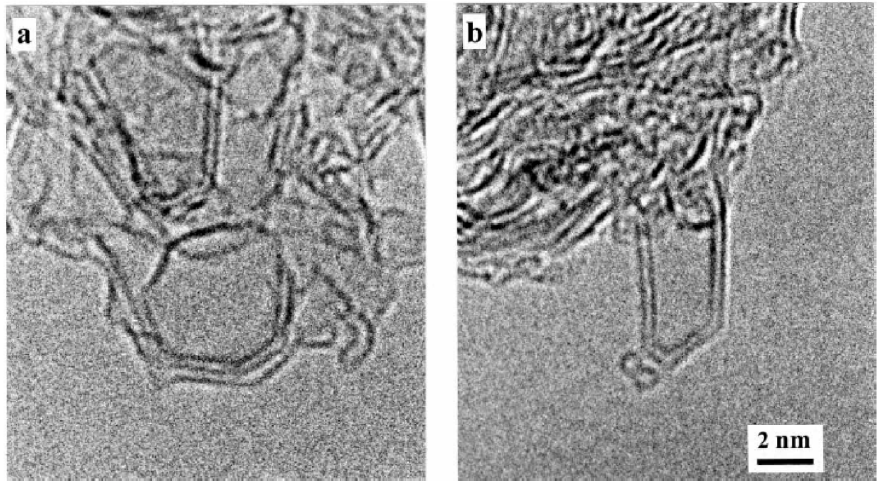
Figure 15. Nanostructures observed by HRTEM in commercial Sigradur glass-like carbon: imperfect nanoparticle ( a ) and nanotube-like structures with small fullerene particles at the tip ( b ). Reproduced with permission from Harris [7]. Copyright Taylor & Francis, 2004.